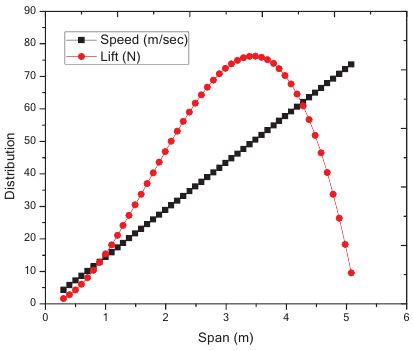
Figure 3. Assumed speed & lift distribution at 15